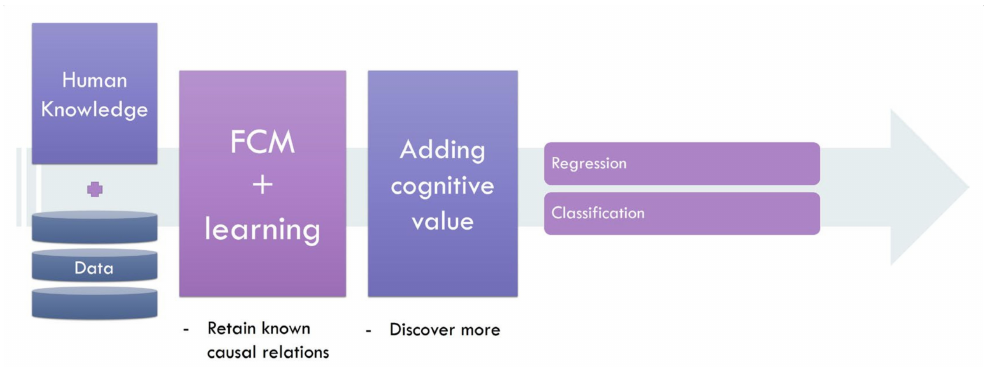
Figure 3. Advancement in fuzzy cognitive maps: learning